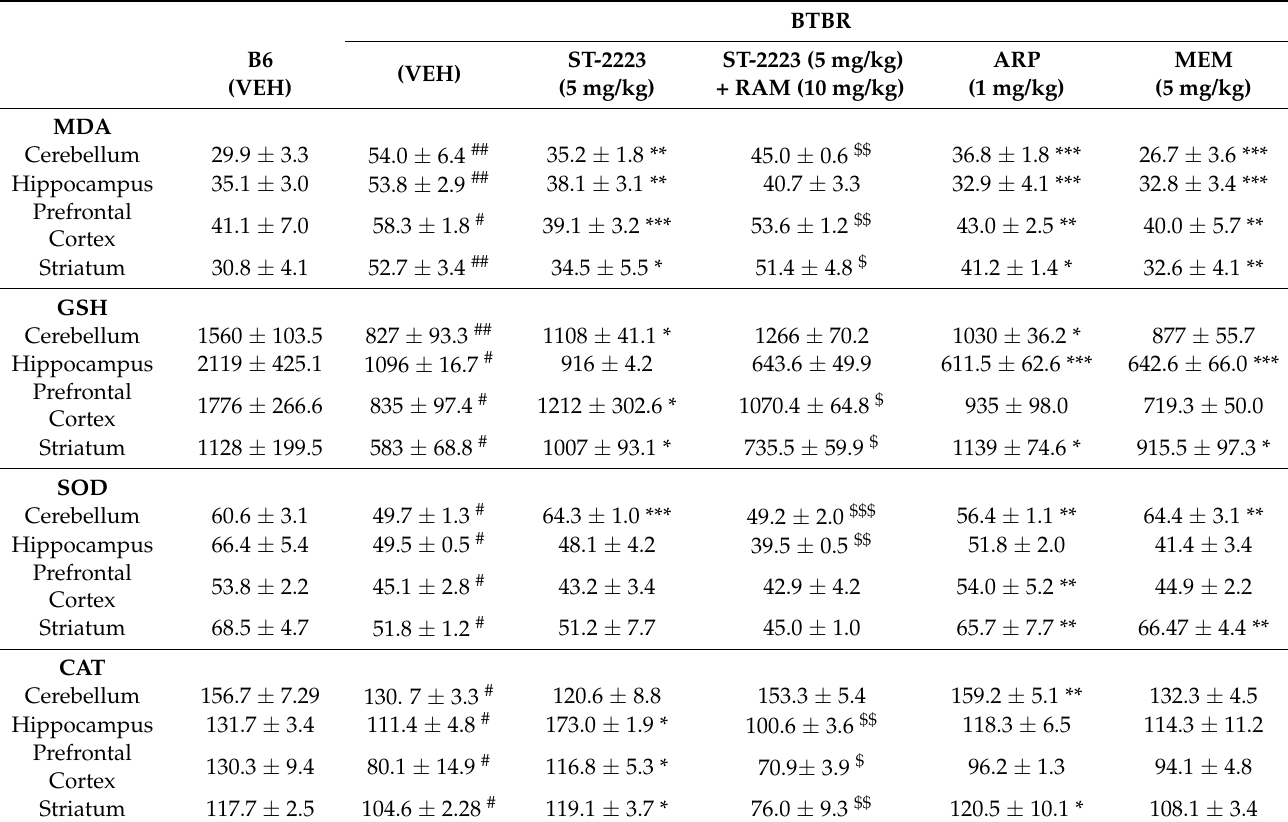
Table 1. ST-2223 mitigated levels of oxidative stress markers in different brain parts of treated BTBR